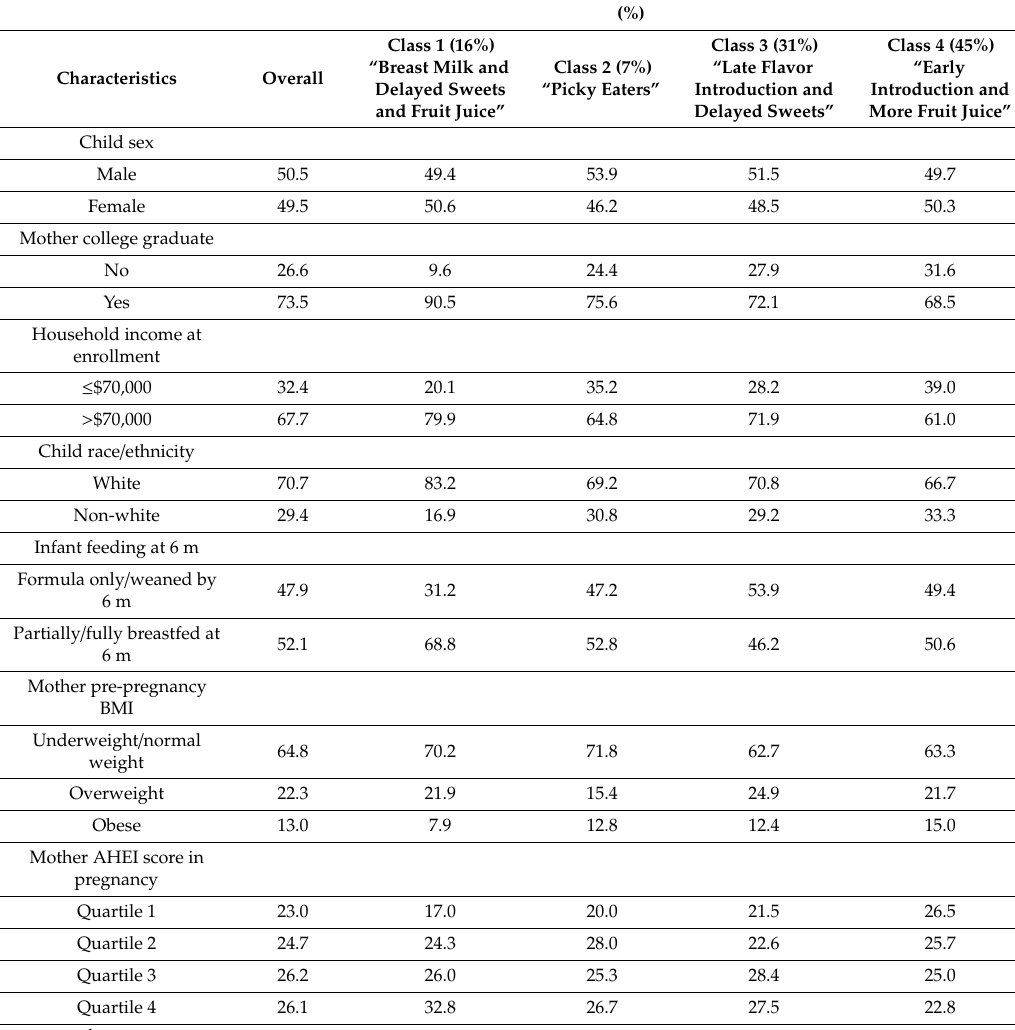
Table 2. Demographic characteristics of 1162 1 Project Viva participants – overall and by pattern of complementary feeding introduction (latent